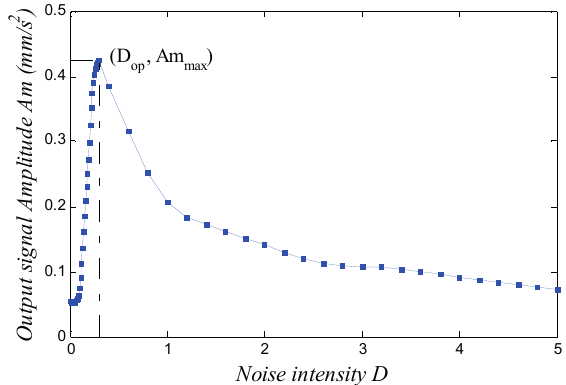
Figure 2. SR of the bistable Duffing equation. ( a ) waveform of input signal; ( b ) spectrum of input signal; ( c ) waveform of output signal; ( d )spectrum of output signal.